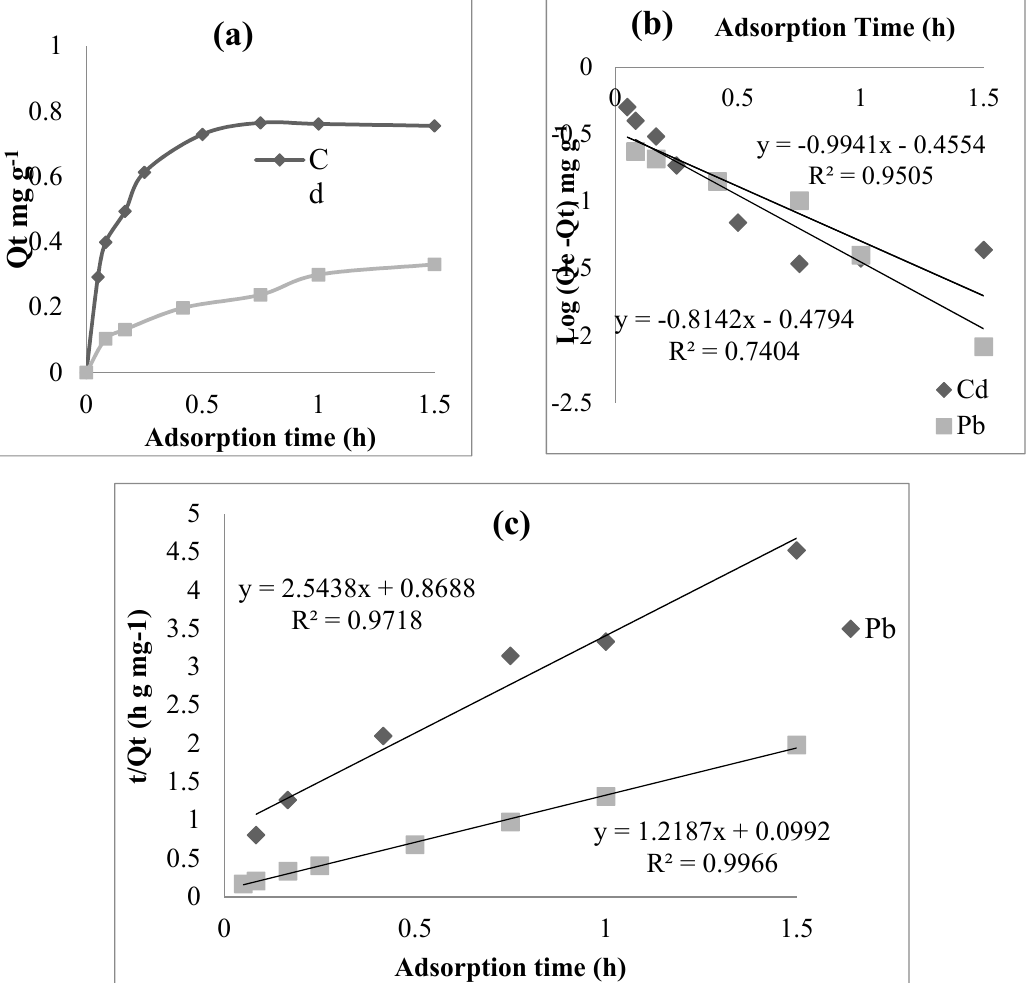
Figure 9. ( a ) E ff ect of time on the adsorption capacity of Cd and Pb ions on powdered biomass, Figure 9. ( a ) Effect of time on the adsorption capacity of Cd and Pb ions on powdered biomass, ( b ) ( b ) Pseudo first-order kinetic model, ( c ) Pseudo second-order kinetic Pseudo first-order kinetic model, ( c ) Pseudo second-order kinetic model. Table 3. Pseudo first-order and pseudo second-order kinetic models for the adsorption of Pb and Cd ions on powdered biomass.